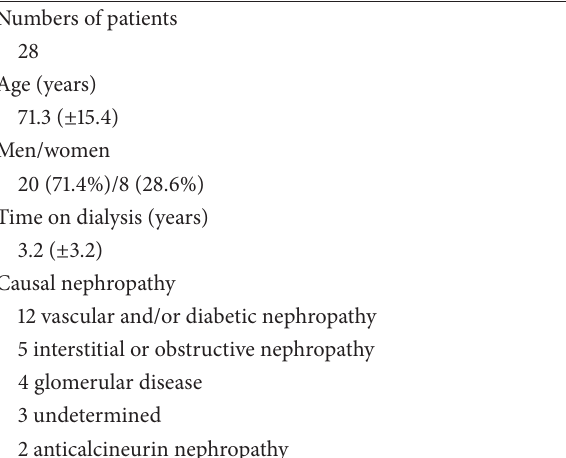
Table 1: Baseline demographic and clinical